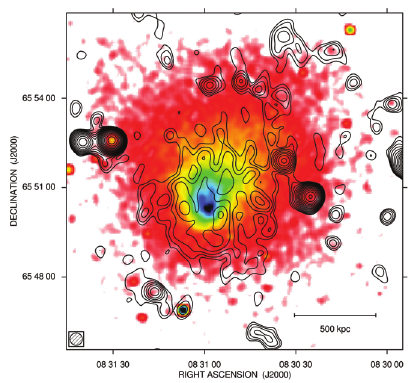
Figure 15. Radio halo in the central region of the galaxy cluster A665. The contours show the total intensity of the 1 . 4GHz radio continuum emission measured with the VLA. The background is an X-ray image from Chandra in the (0 . 8 − 4)keV band [53].